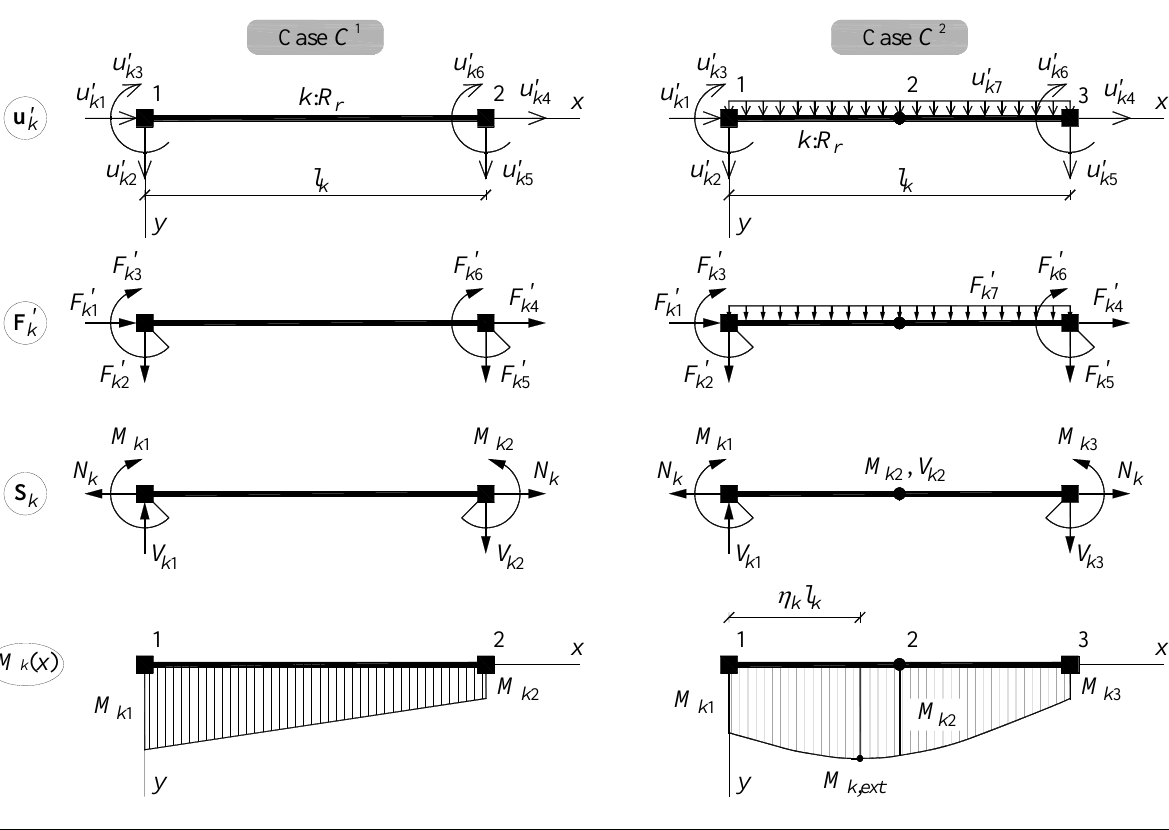
Fig. 3. Finite element